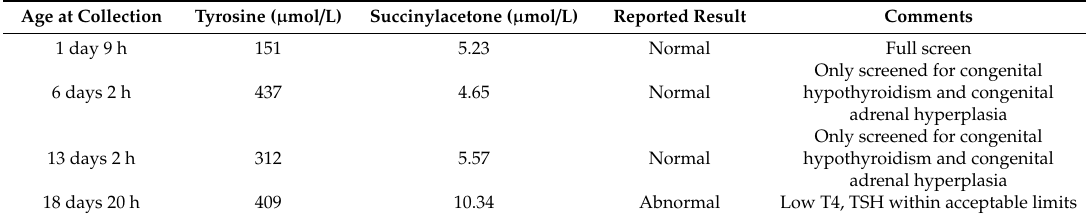
Table 1. Tyrosine quantitation from the patient’s original DOL 1 dried blood spot analysis (top line, bolded) with retrospective re-analysis of stored blood spot samples quantitating both tyrosine (cuto ff < 280 µ mol / L) on the subsequent 3 samples and SUAC on all 4 samples. There was no validated cuto ff for SUAC given that it was not part of New Jersey’s TT1 screening protocol at the time. Reported screening results from the New Jersey NBS Laboratory and comments on results are shown on the right. The patient’s repeated screening test on DOL 18 was flagged for low T4 (8.0 µ g / dL with cuto ff > 14.5 µ g /